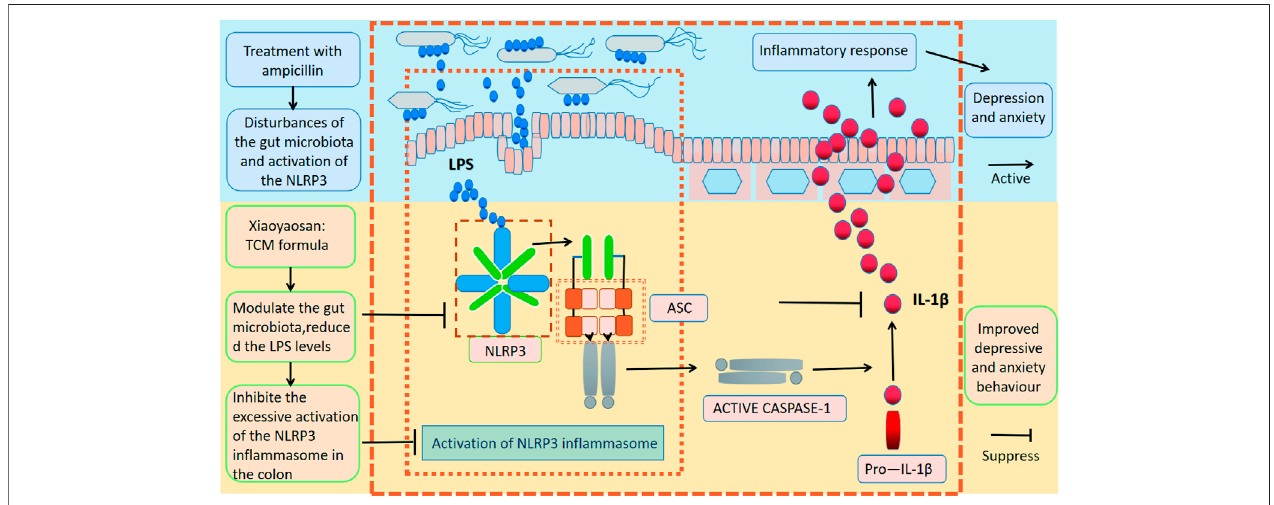
FIGURE 7 | Xiaoyaosan suppresses anxiolytic-like behaviors and improve depressive behavior by modulating the gut microbiota and inhibiting the excessive activation of the NLRP3 in fl ammasome in the colon.